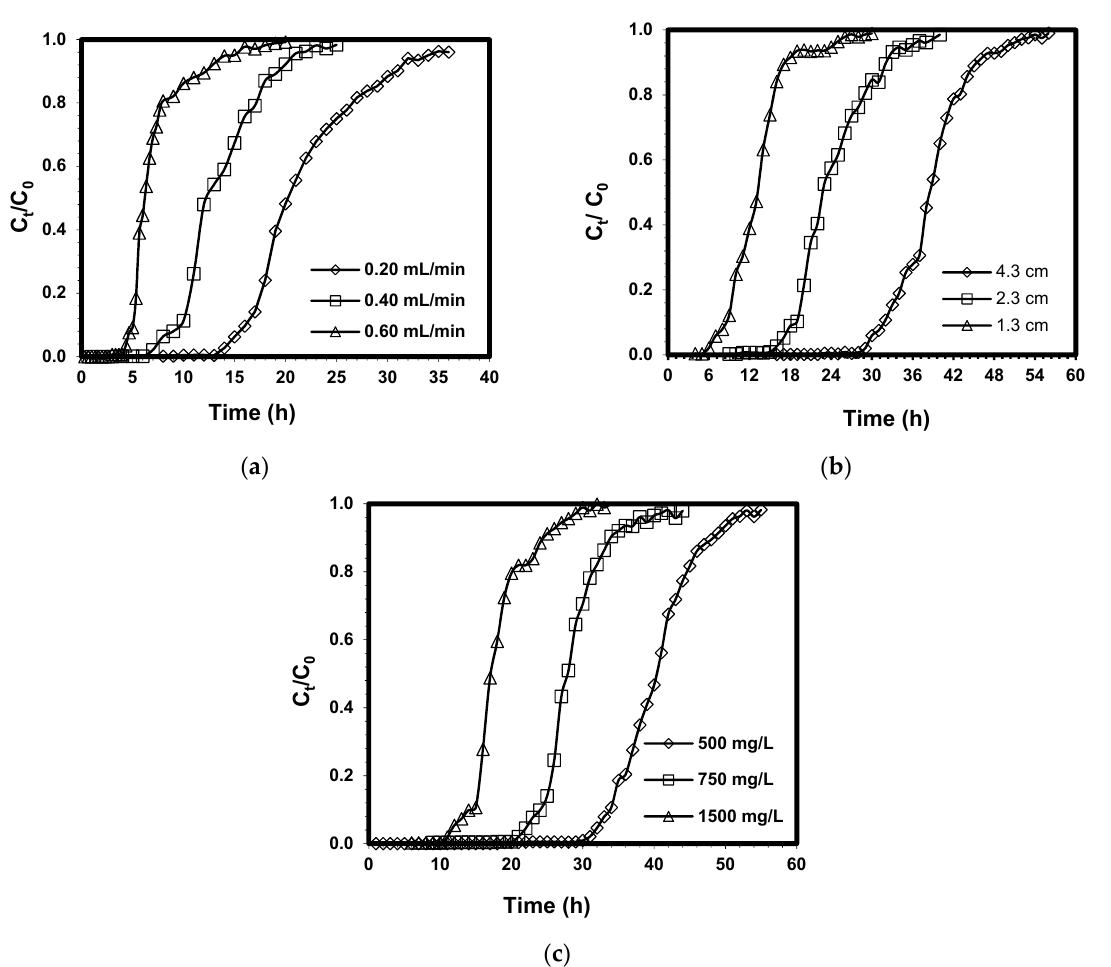
Figure 3. Effect of ( a ) flow rate, ( b ) bed height, and ( c ) initial Pb(II) concentration on the breakthrough capacity of fixed-bed CCB for the removal of Pb(II). Table 1. Length of mass transfer zone, adsorption capacity of Pb(II) at breakthrough, and adsorption capacity of Pb(II) at exhaustion under various operating conditions.